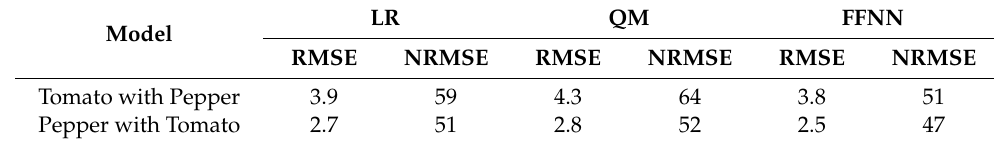
Table 4. Results in (%) of day-ahead forecasting methods using base model.